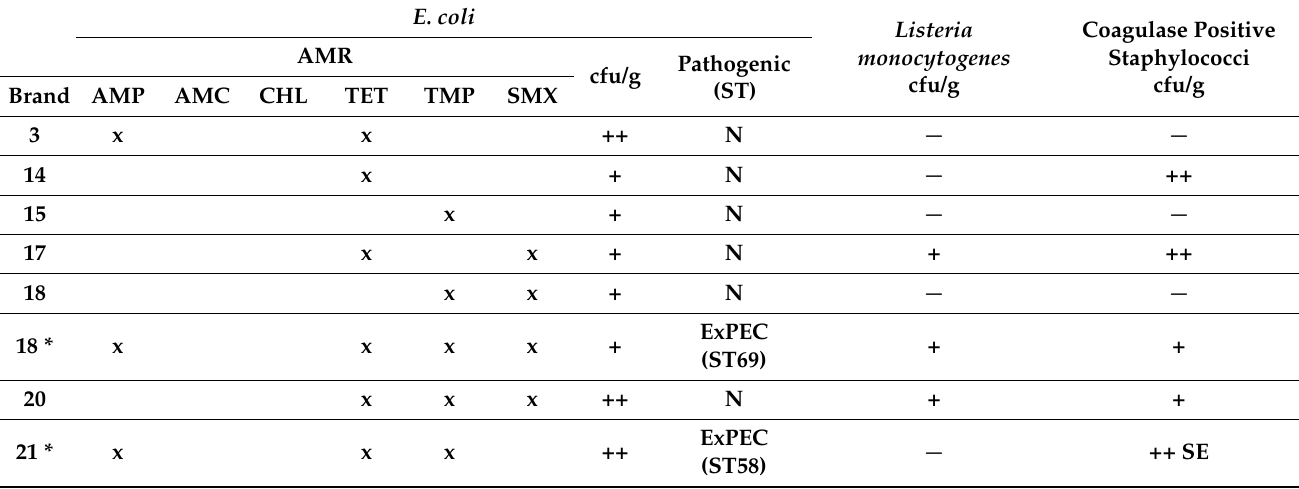
Figure 2. Core-genome clustering analysis of Listeria spp. isolates. ( A ) For L. monocytogenes (15 isolates), the Minimum Spanning Tree (MST) was constructed based on the cgMLST 1748-loci Pasteur schema [30]. Each circle (node) contains the strain’s designation and represents a unique allelic profile, with numbers on the connecting lines representing allelic distances (AD) between nodes. Straight and dotted lines reflect nodes linked with ADs below and above a threshold of seven ADs, which can provide a proxy to the identification of genetic clusters with potential epidemiological concordance [34]. The traditional seven-loci MLST classification is also indicated. ( B ) For L. innocua (20 isolates), the MST was constructed based on a core-genome SNP-based alignment (comprising 93% of the L. innocua genome size) involving a total 170 variant sites. Each circle (node) contains the strain’s designation and represents a unique SNP profile, with numbers on the connecting lines representing SNP distances between nodes. Straight and dotted lines reflect nodes linked with a SNP distance below and above a threshold of 15 SNPs. For both panels, data visualization was adapted from GrapeTree dashboard [33], with the node colors reflecting the producer. AMR E. coli and the concomitant presence of L. monocytogenes and Coagulase Positive